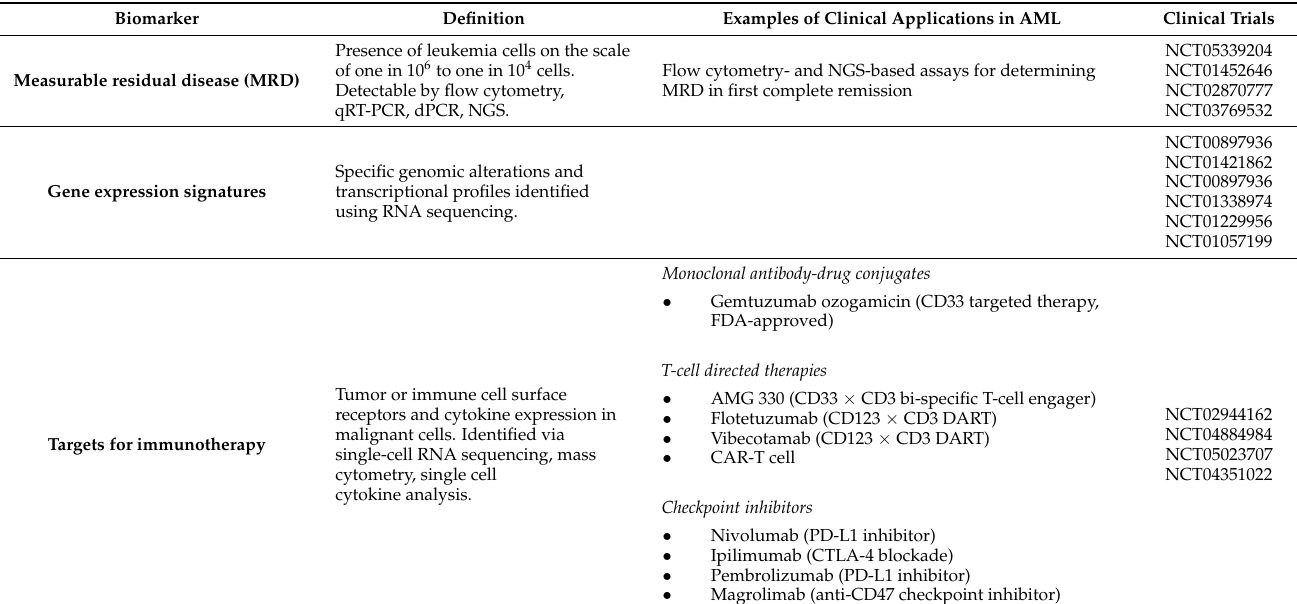
Table 1. Emerging biomarkers in AML. qRT-PCR, quantitative real-time PCR; dPCR, digital PCR. NGS, next generation